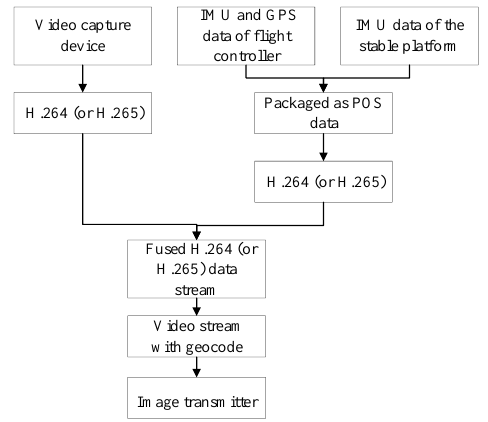
Figure 6. The flowchart of video